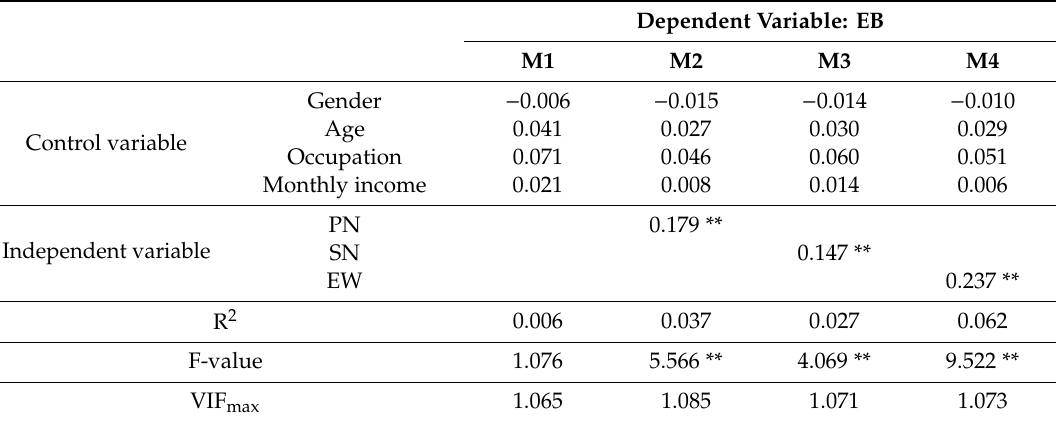
Table 4. Regression results of factors a ff ecting environmental protection